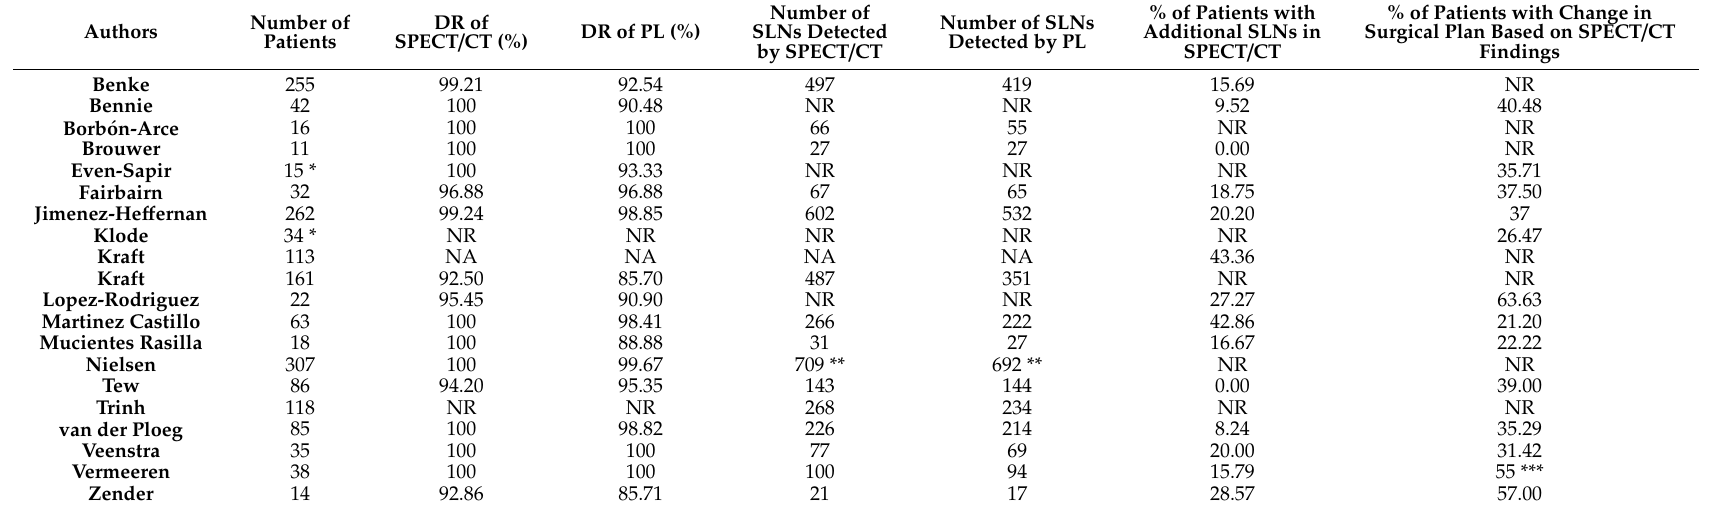
Table 2. The data extracted from the twenty studies selected for the